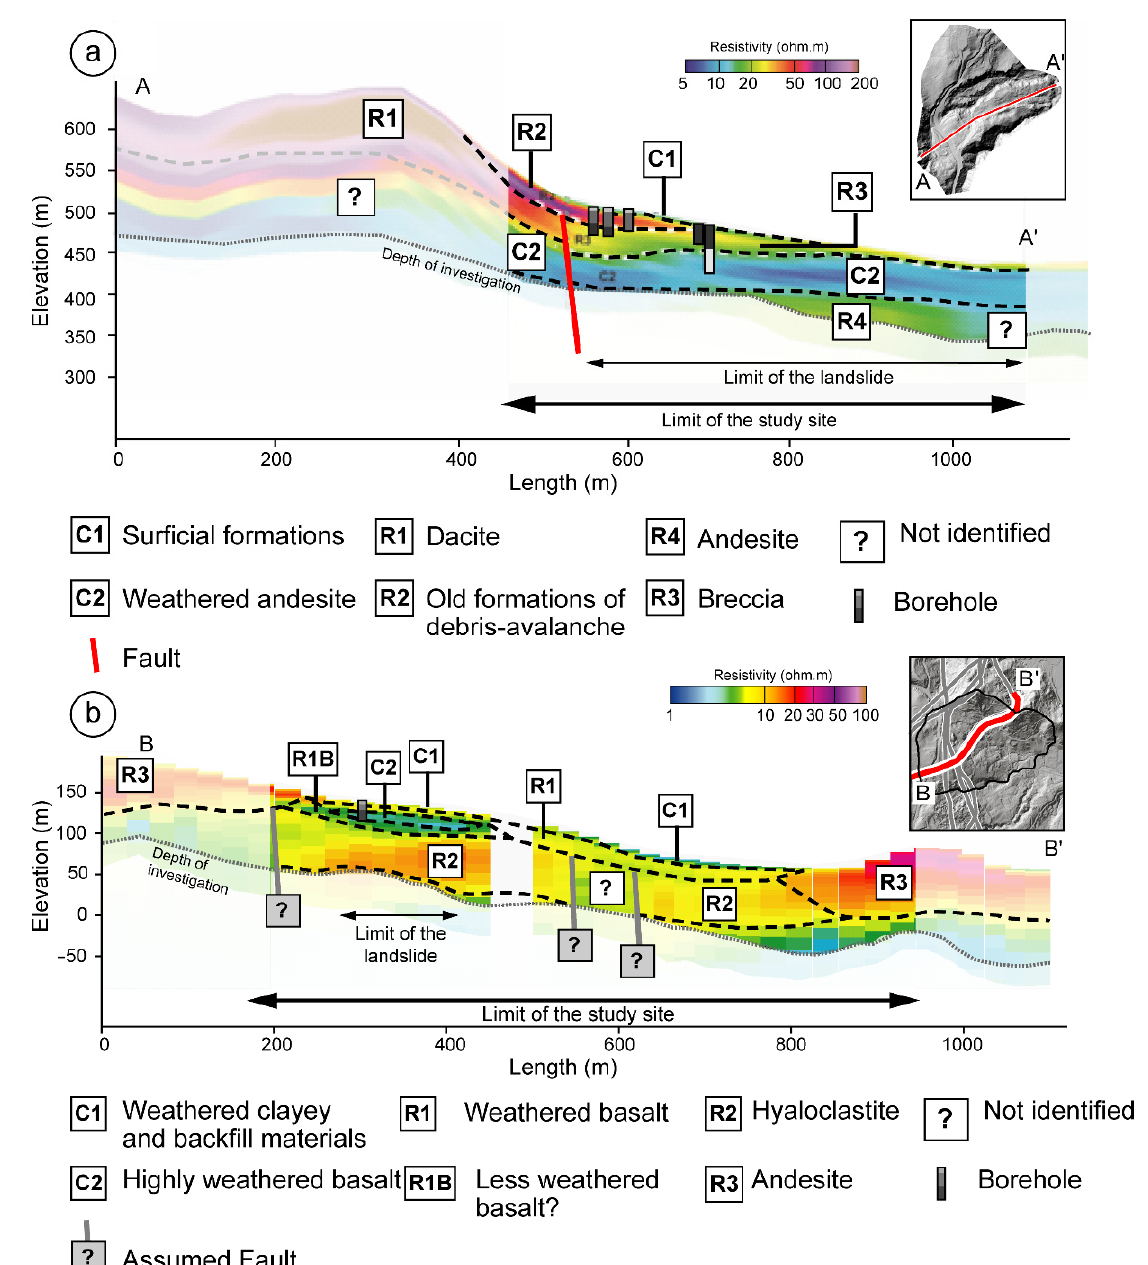
Figure 7. Interpreted resistivity profiles. ( a ) La Médaille landslide (hillshade map is produced with Helimap DTM, 2013); ( b ) Morne-Figue area (hillshade map is produced with Litto3D DTM, IGN, 2010).